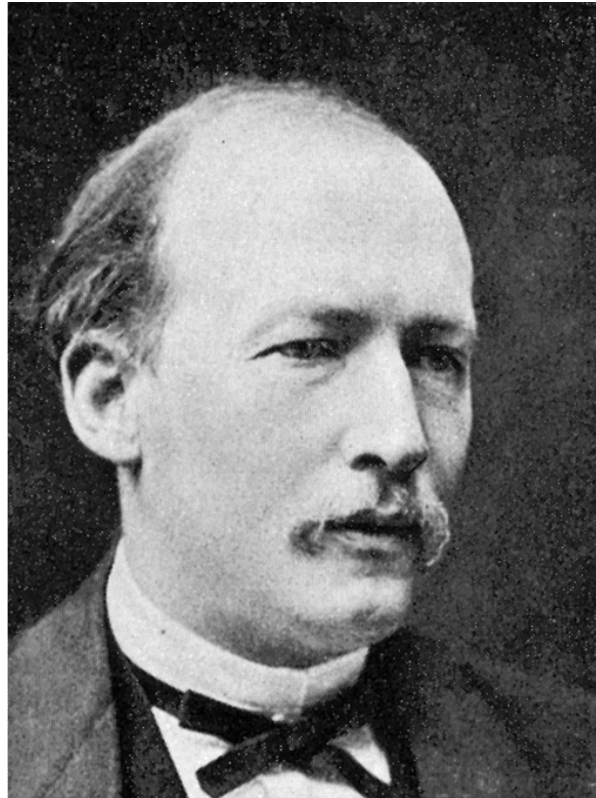
Figure 6. Niels H. C. Ho ff meyer (1835–1884) (MI, 1972).